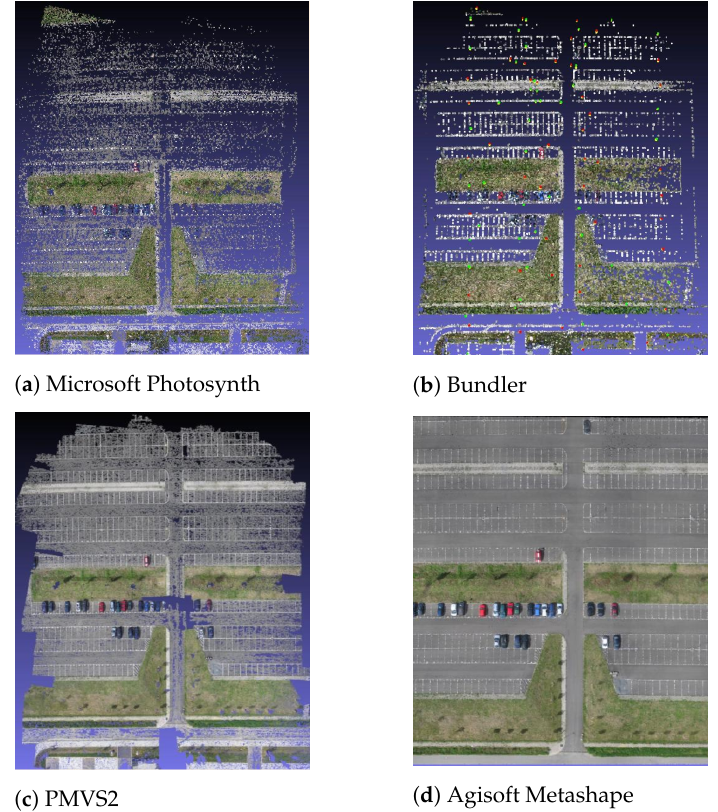
Figure 2. Comparison of different programs. ( a ) point cloud produced by Microsoft Photosynth. Several gaps are present in the point cloud. Features (cars) are barely visible; ( b ) Bundler’s point cloud presents similar results as ( a ). Gaps are present as well as barely detectable features; ( c ) PMVS2 presents a clearer cloud compared to ( a , b ). The point cloud is almost complete except for the edges and at the center. In this case, the cars are very distinguishable; ( d ) Agisoft Metashape produced a complete point cloud with no gaps. Adapted from